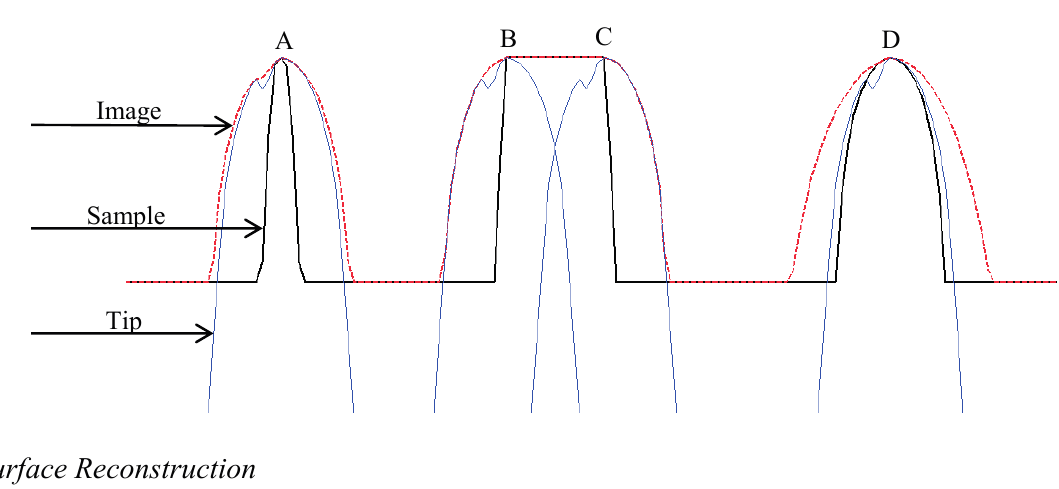
Figure 1. Comparison of the sample, image and the inverted